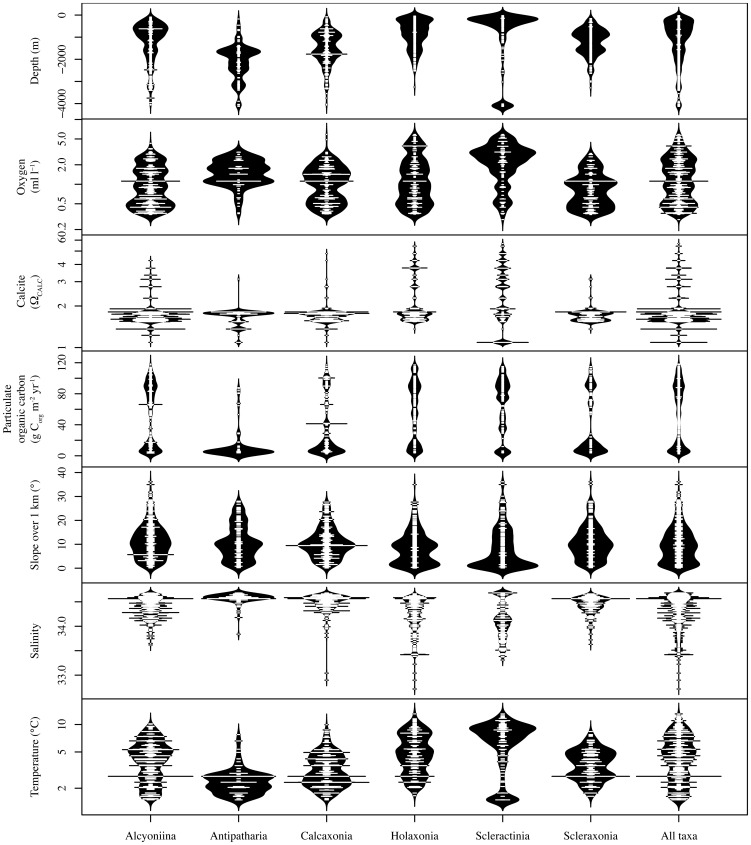
Bean plots of coral presences intersected with the environmental, physical and chemical variables used in the models (the small lines in the center of each bean shows individual coral presence points).The bean itself is a density trace that is mirrored to show as a full bean [56].